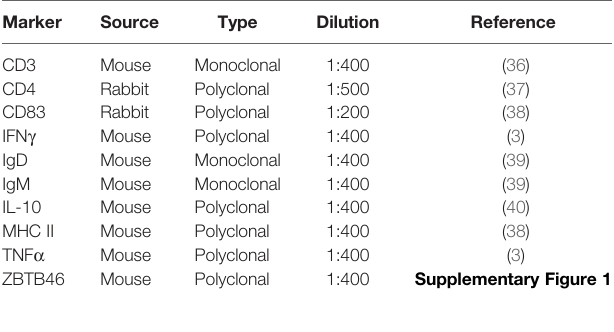
TABLE 2 | Primary antibodies for indirect ELISA.